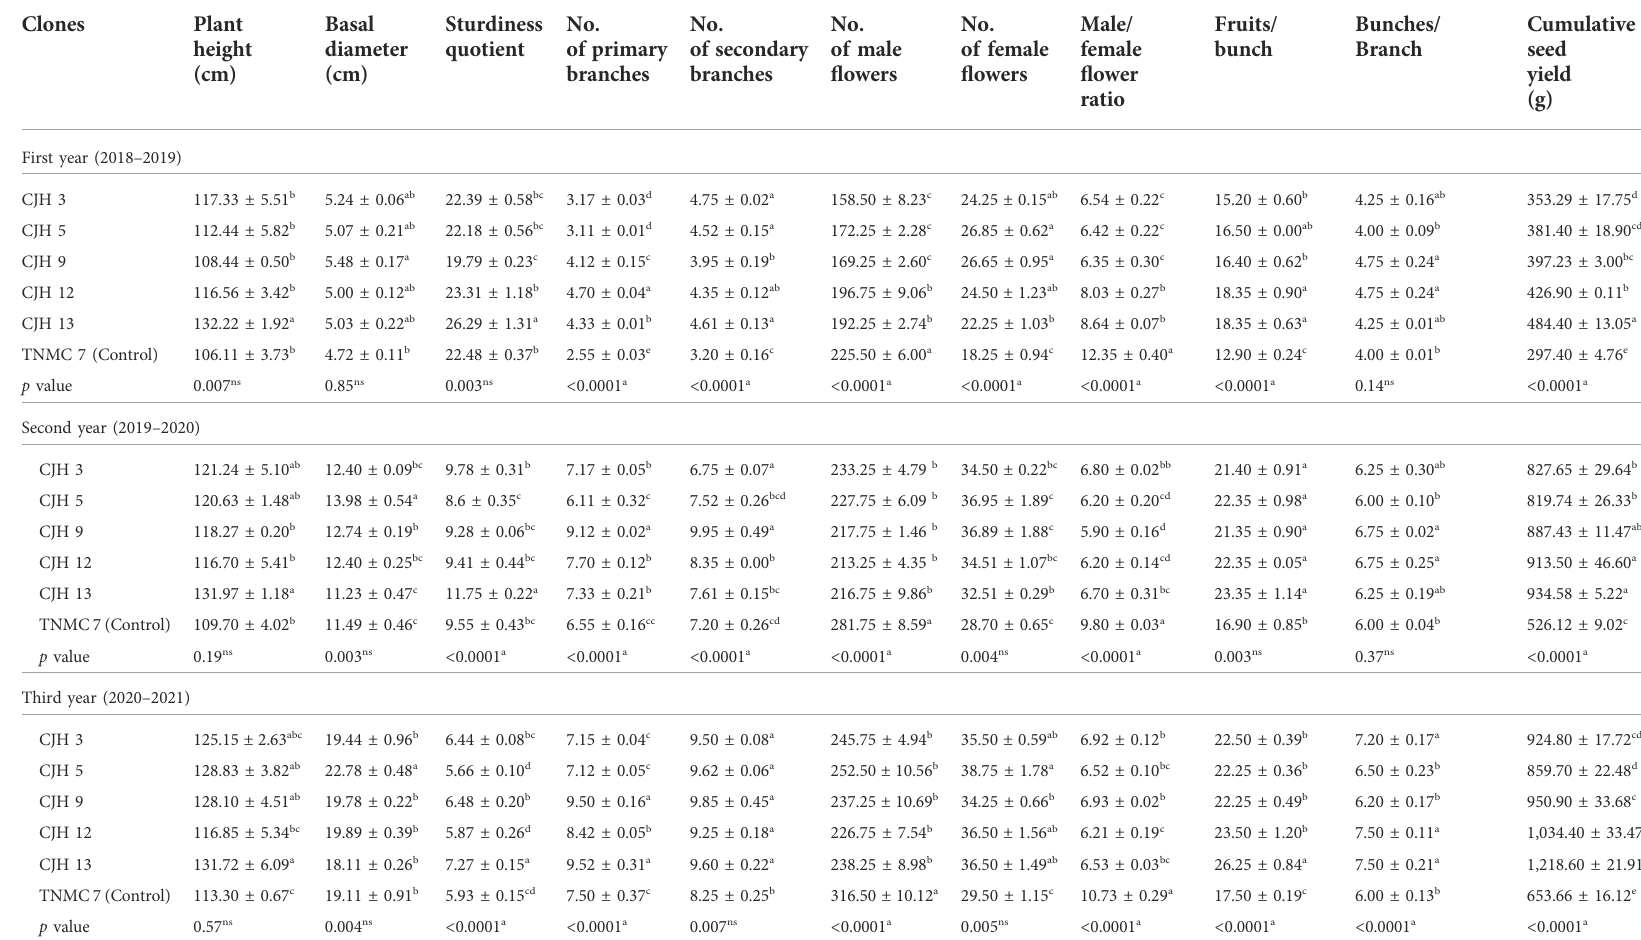
TABLE 1 Mean performance in growth parameters of Jatropha hybrid